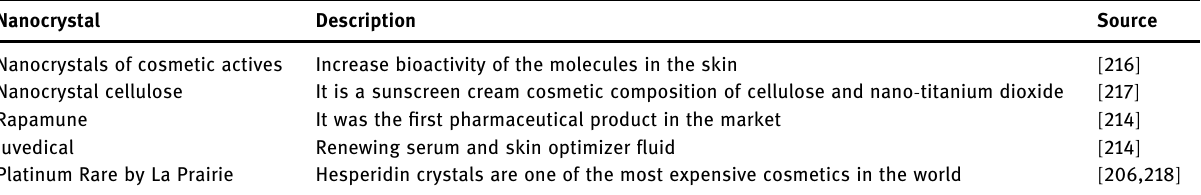
Table 10: Uses of